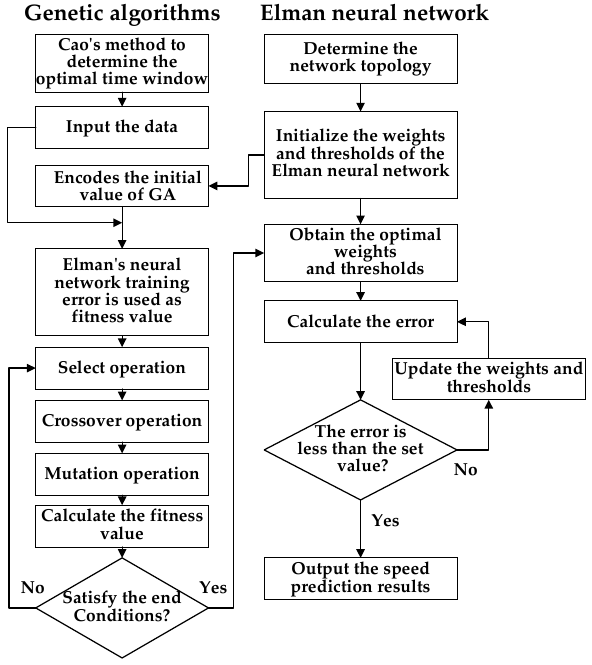
Figure 1. Flow chart of GA – Elman algorithm prediction. Step 1: Obtain the data and perform sample pre-processing. Determine the basic structure of Elman neural network and related network parameters and determine the time window m by Cao’s